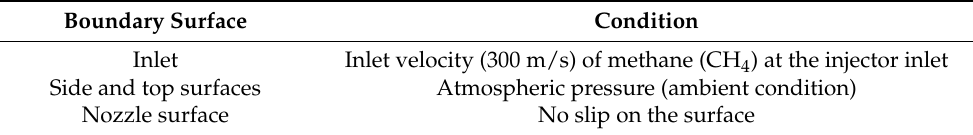
Table 2. Boundary and initial condition.